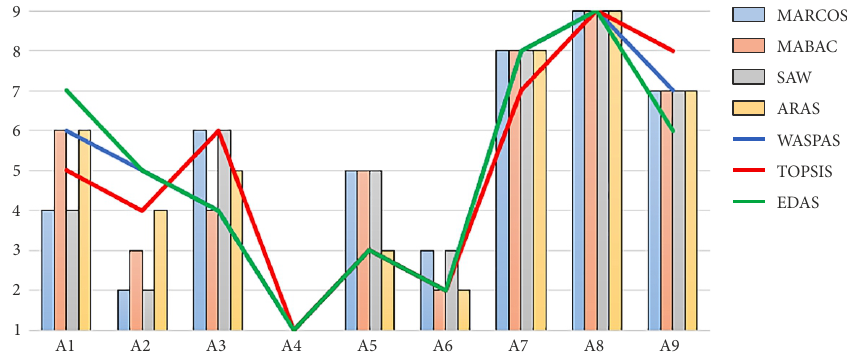
Figure 5. Ranks of the alternatives using different